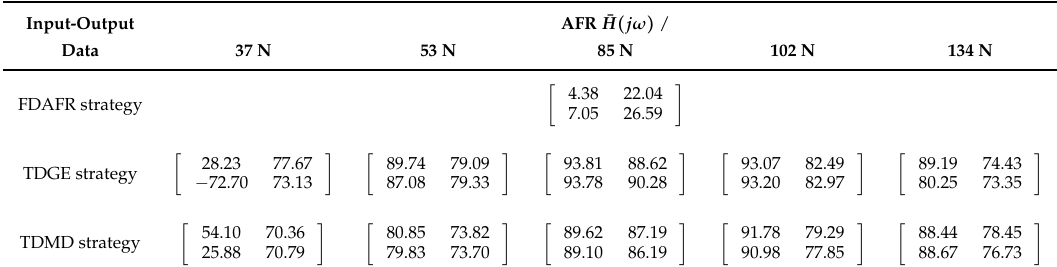
Table 1. Fit values for each identification strategy.